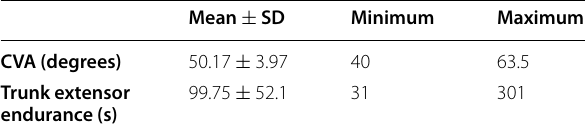
Table 3 Descriptive statistics of the CVA and trunk extensor endurance of the study group